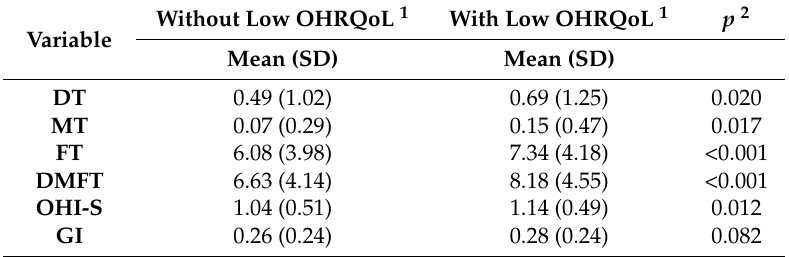
Table 4. Clinically-assessed oral health variables among students with and without low oral health-related quality of life